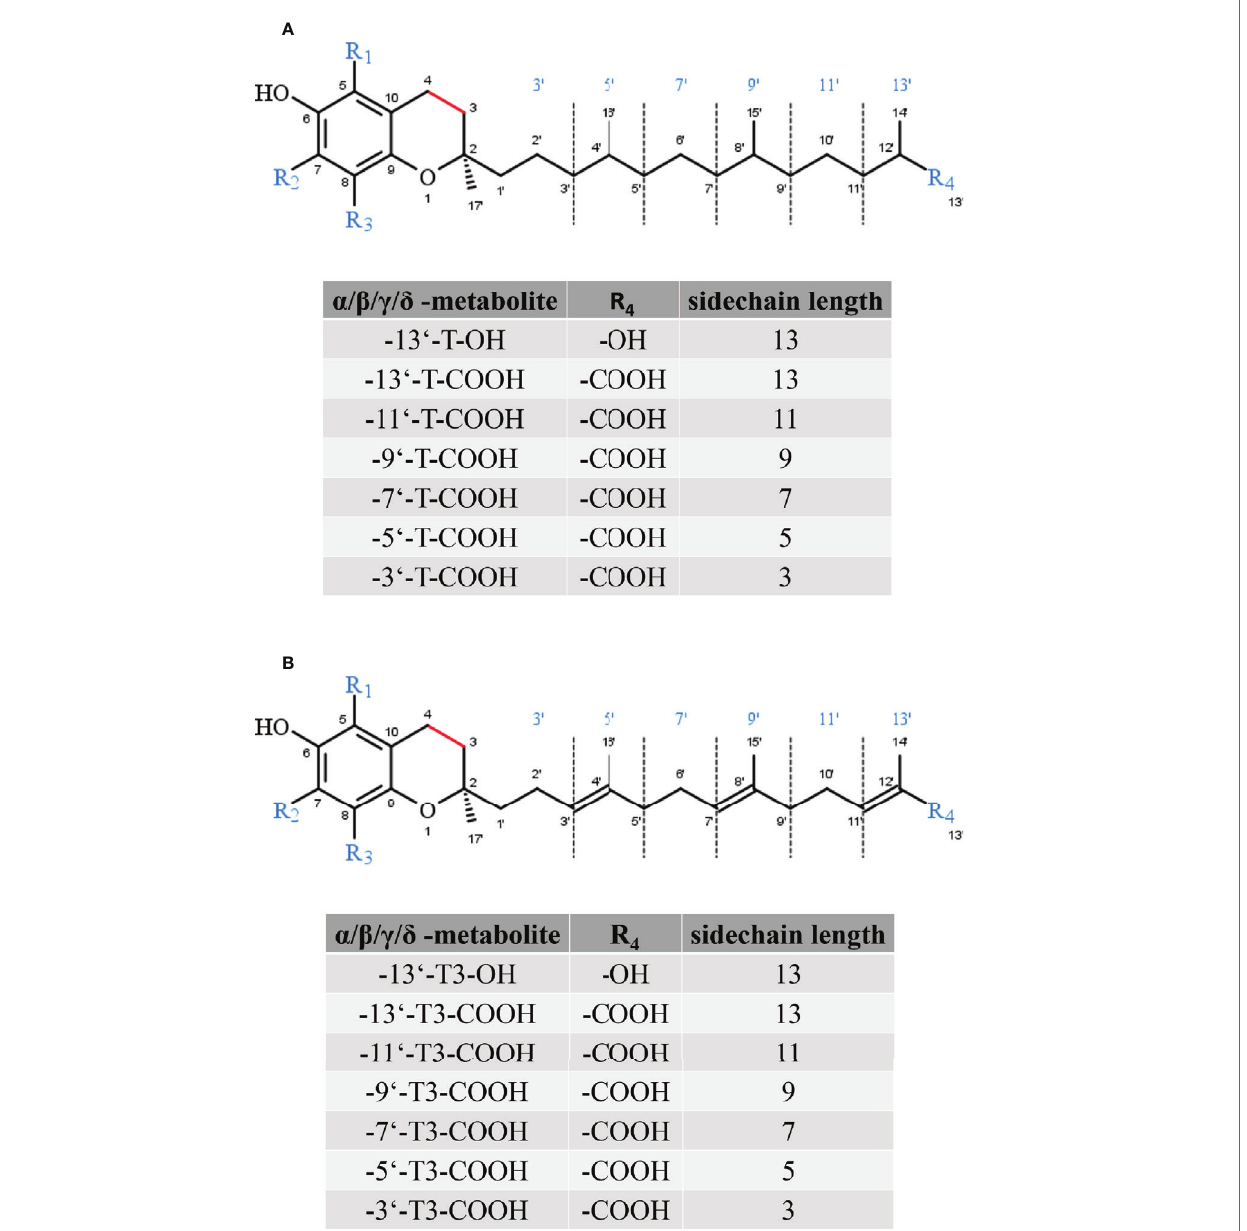
FIGURE 3 | Core structure of (A) tocopherol and (B) tocotrienol metabolites. The substitutions R1 to R3 are given in Figure 2 (A) and (B)